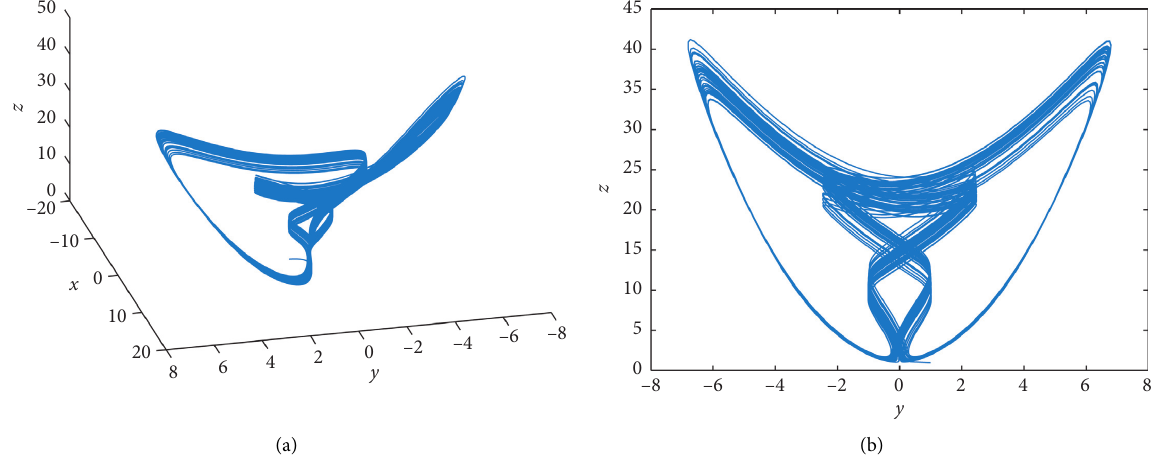
Figure 5: Phase portraits of the fractional system with α � 0 . 995.